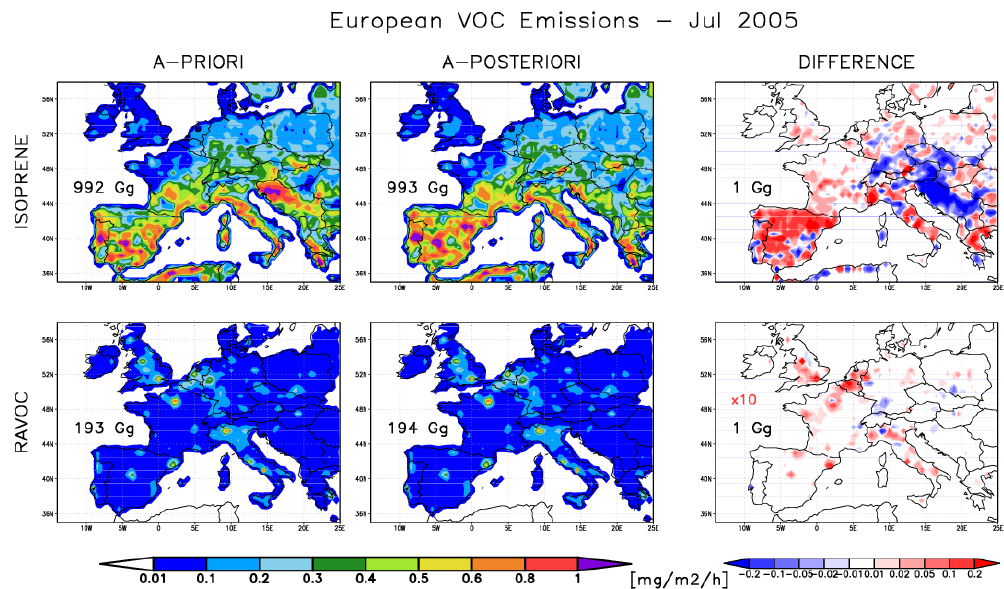
Fig. 4. a-priori and a-posteriori VOC emission estimates (mgm − 2 h − 1 ) for July 2005. Differences of RAVOC emissions are multiplied by 10 to fit the same colour scale of isoprene emissions. Monthly total emissions (Gg) are shown inset.